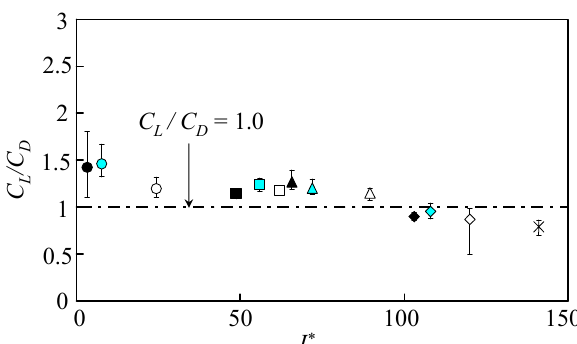
Fig. 14 Lift-to-drag ratio C L /C D versus inertia-moment ratio I * , for several values of Reynolds number Re at depth-to-width ratio λ = 0.3, aspect ratio AR = 10, C = 3.86 × 10 2